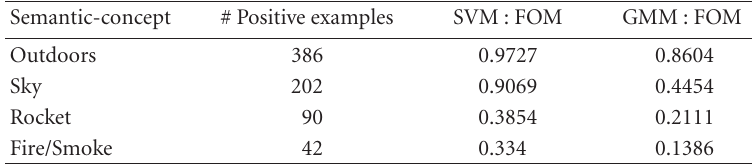
Table 1: Comparing test set accuracy of visual concept classification for the two methods.